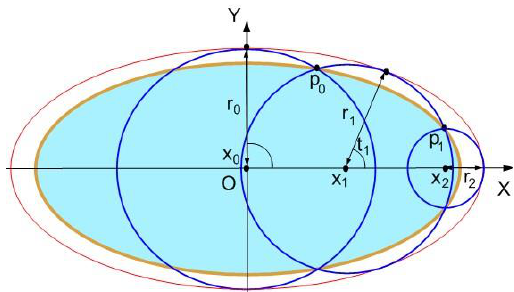
Figure 3. Illustration of the solution obtained at Step 6 of the last iteration of the algorithm for Stage 1 .